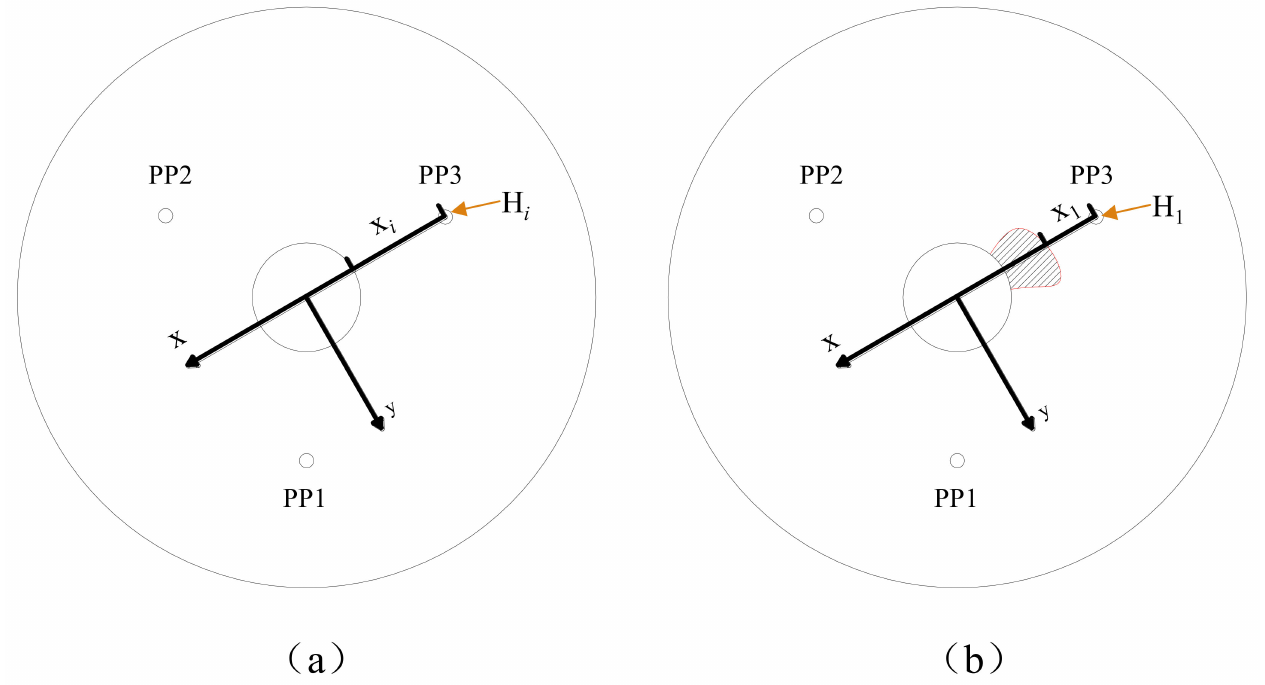
Figure 10. Schematic illustration of BEP development at two key stages of a test on graded angular sand: ( a ) before channel initiation (Stage a ); ( b ) after channel initiation (Stage b ) (stage letters correlate with Figure